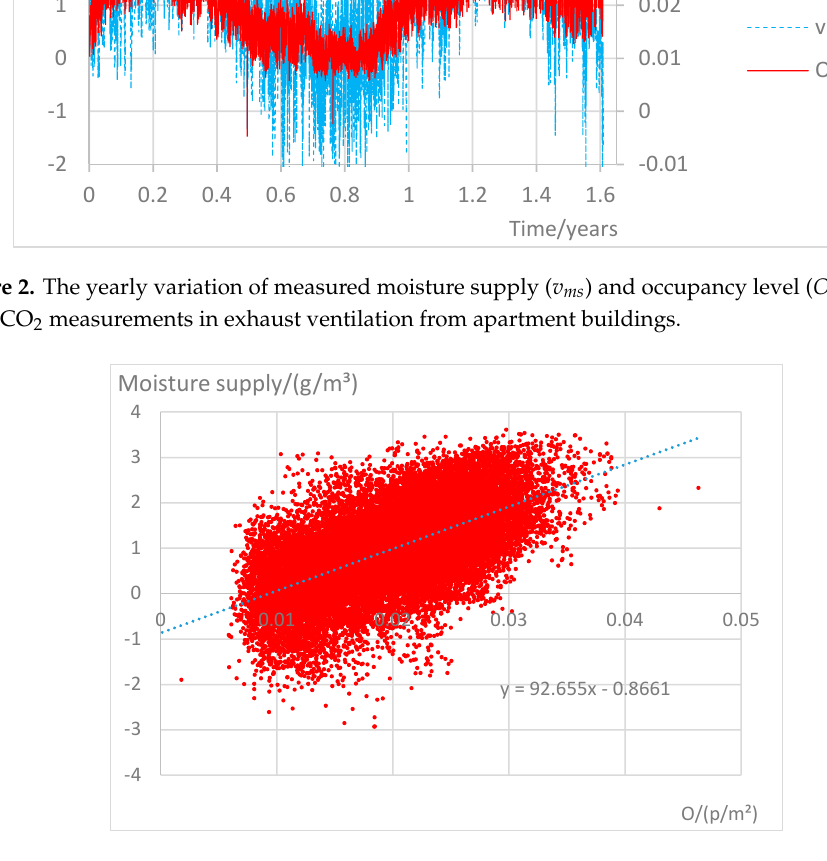
Figure 3. The linear regression curve describing the relation between moisture supply and occupancy level.